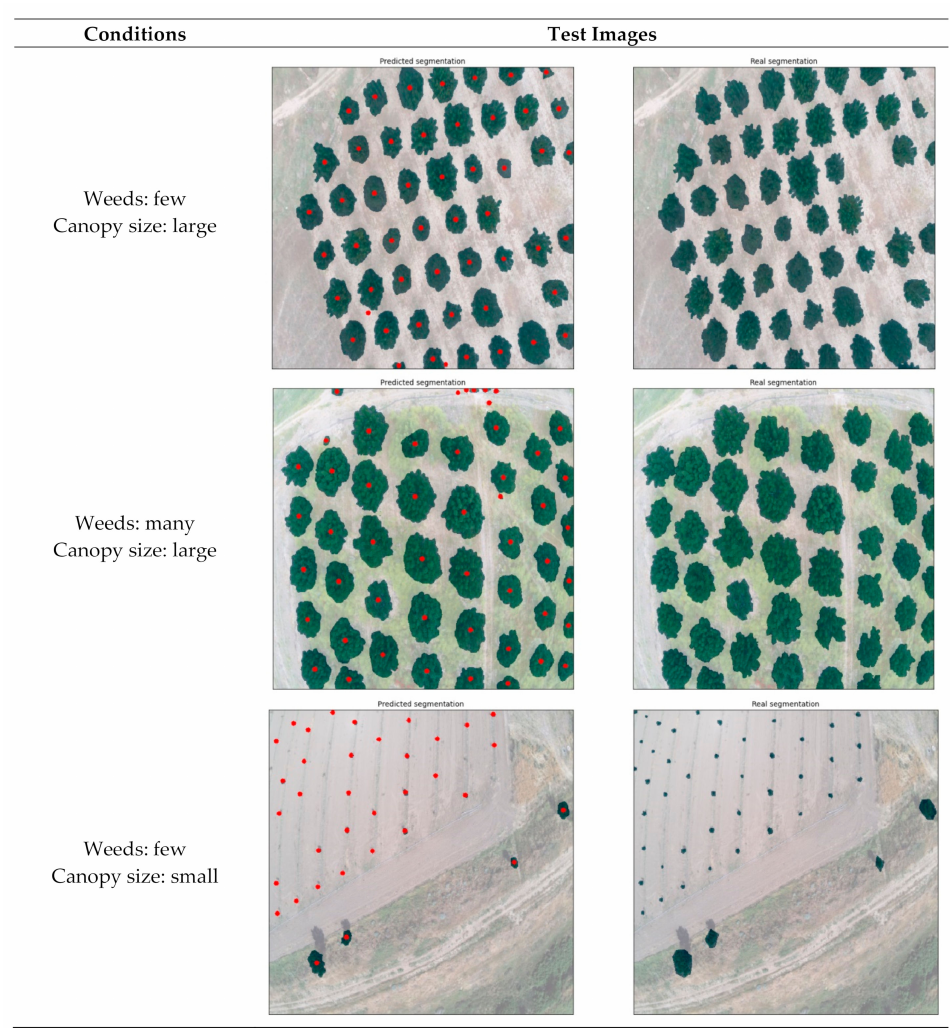
Figure 7. Results of indicative RGB images covering a range of different